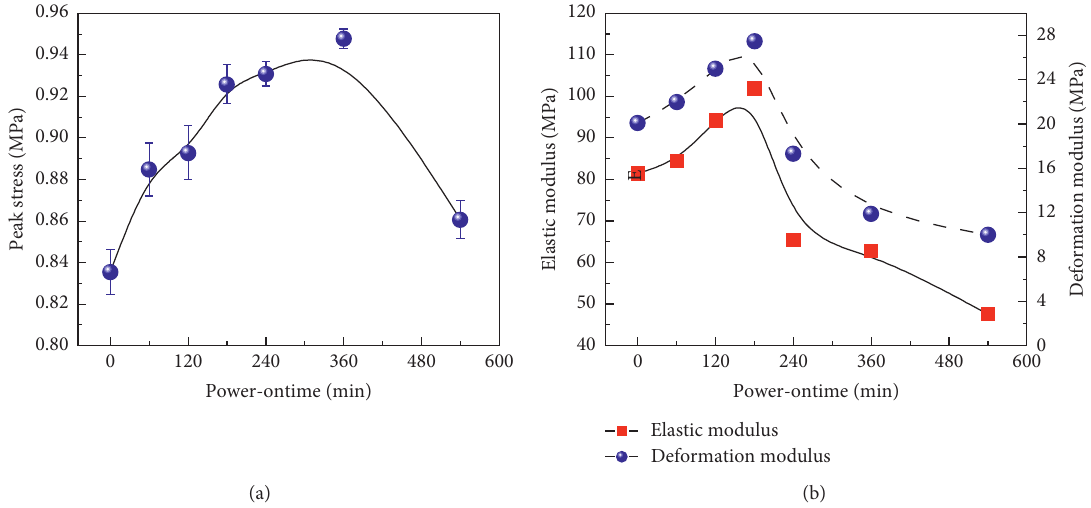
Figure 9: The change in (a) the peak strength, (b) elastic modulus, and deformation module of HWBM samples after electrochemical modification with different power-on